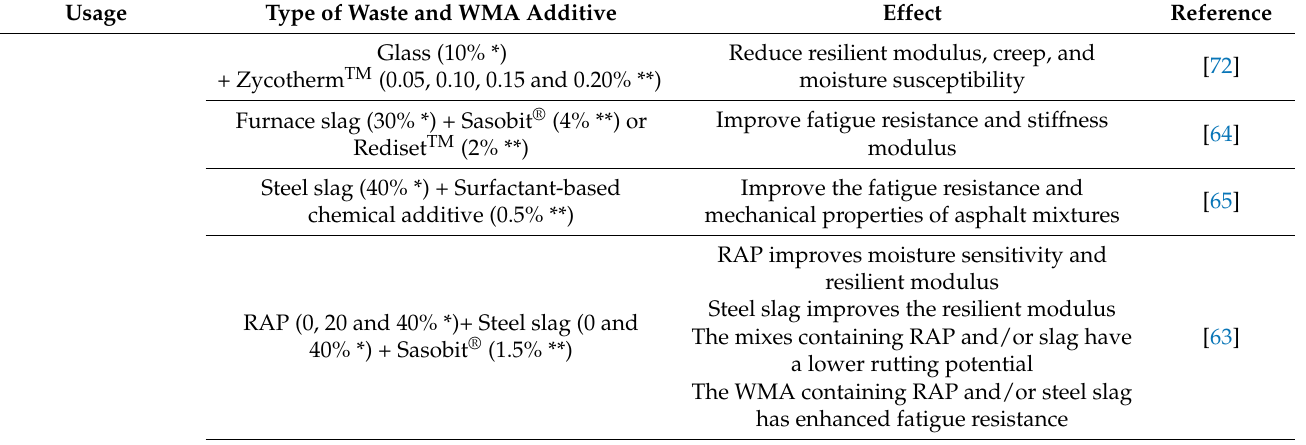
Table 1. The recycled materials used in